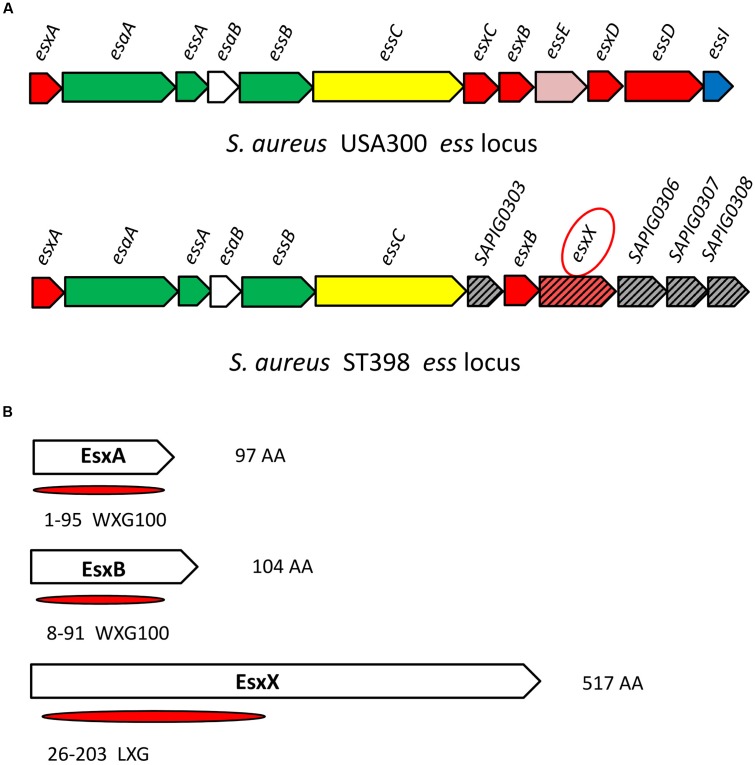
Location of esxX in the CA-SA ST398 ess locus and its domain organization.
(A)
ess locus of USA300 and ST398. Gene and protein colors indicate FtsK-SpoIIIE domain-ATPases (yellow); secreted protein (red); transmembrane protein (green); cytoplasmic protein (white); hypothetical protein (slash pattern); protein of unknown function (gray); EssE (pink); EssI (EssD inhibitor, blue). (B) EsxA and EsxB, both members of the WXG100 superfamily. EsxX, a 517 aa protein, has an LXG domain at the N-terminal and belongs to the WXG superfamily.